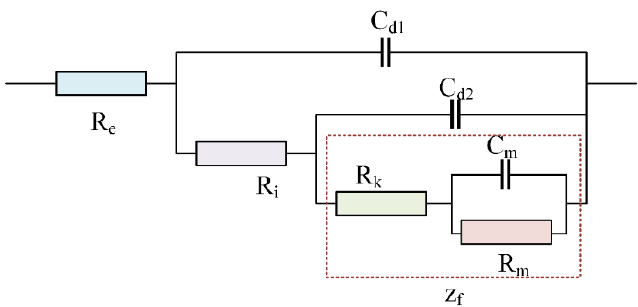
Figure 38. Schematic representation of the equivalent circuit of a typical metal air battery, i.e., Zn air battery battery [130].